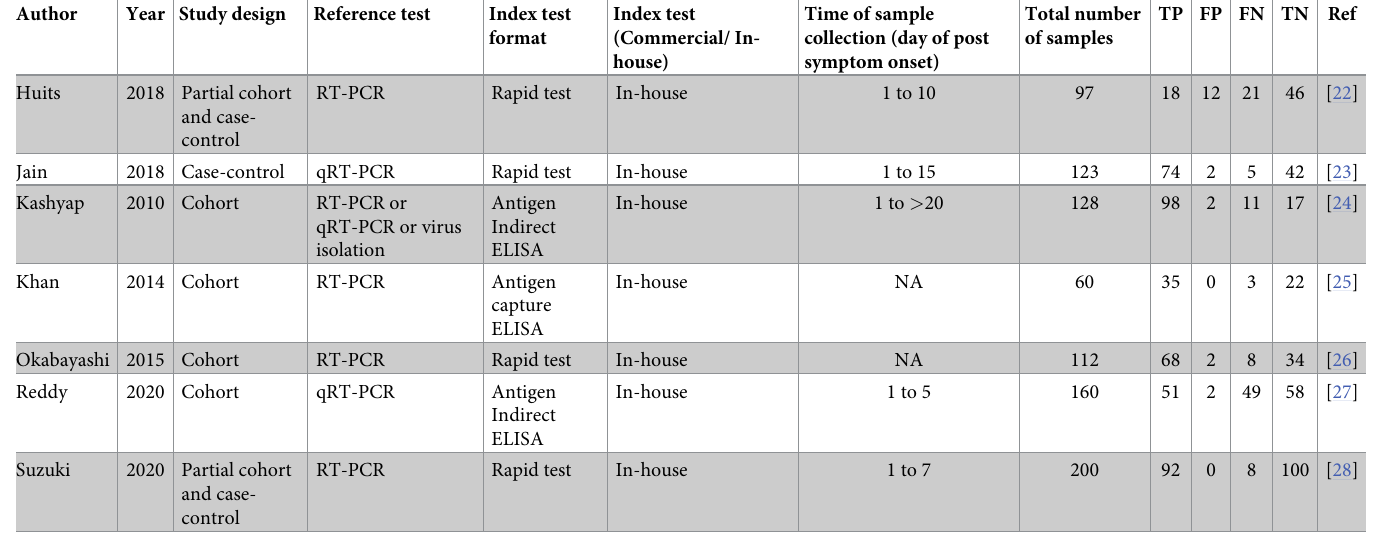
Table 1. Characteristics of the studies on antigen detection tests included in the